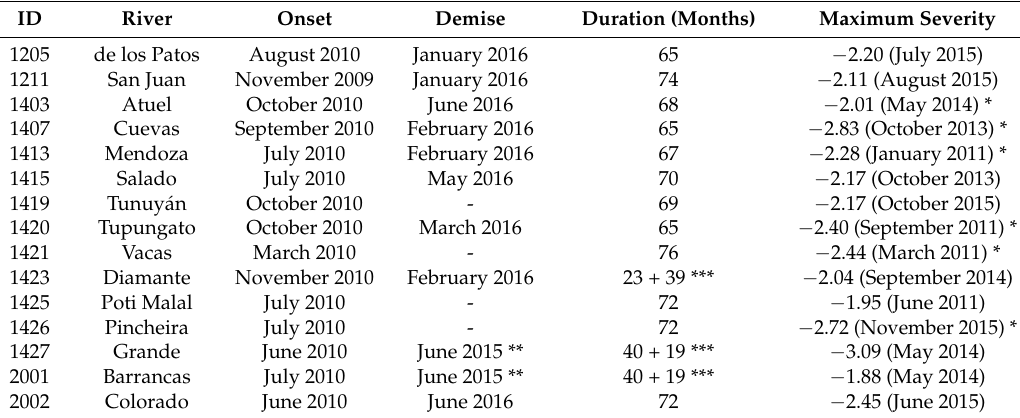
Table 3. Characteristics of the 2010–2015 hydrological drought.